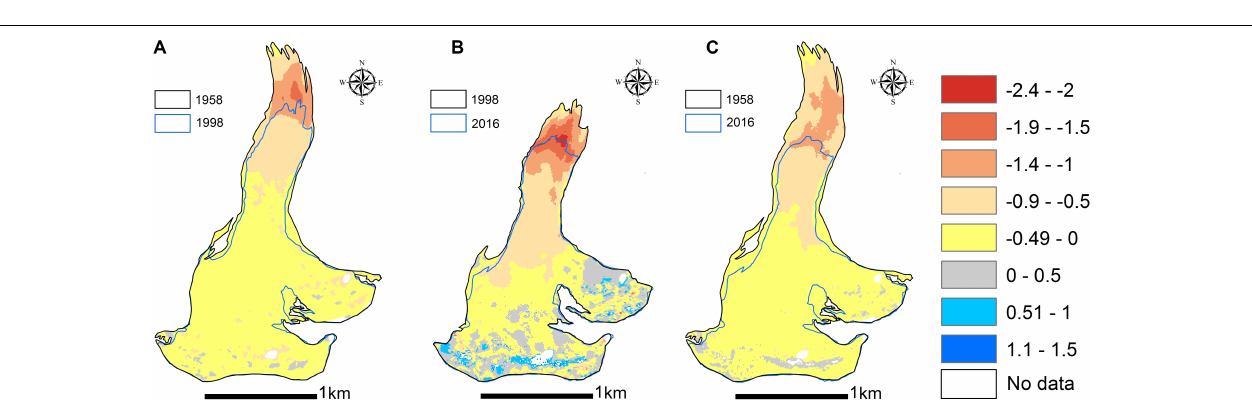
FIGURE 3 | Changes in surface elevation of the Central Tuyuksu glacier (m): (A) 1958–1998; (B) 1998–2016; (C) 1958–2016. The solid line shows the glacier area at the beginning and at the end of each assessment period.